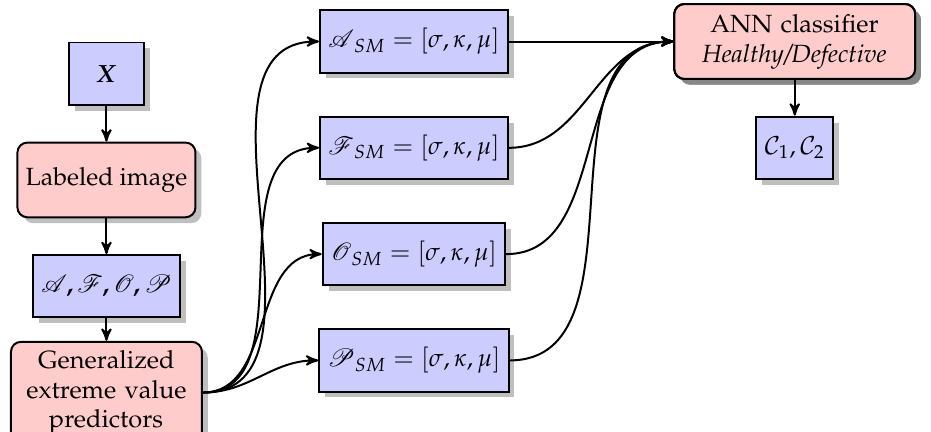
Figure 9. The methodology used in statistical modeling for each disease and defect. Generalized extreme value parameters are the statistical predictors such as scale ( σ ), shape ( κ ), and location ( µ ). They are the inputs to be classified using a neural network. The output is the class raspberry healthy ( C 1 ) or the class raspberry defective ( C 2 ).